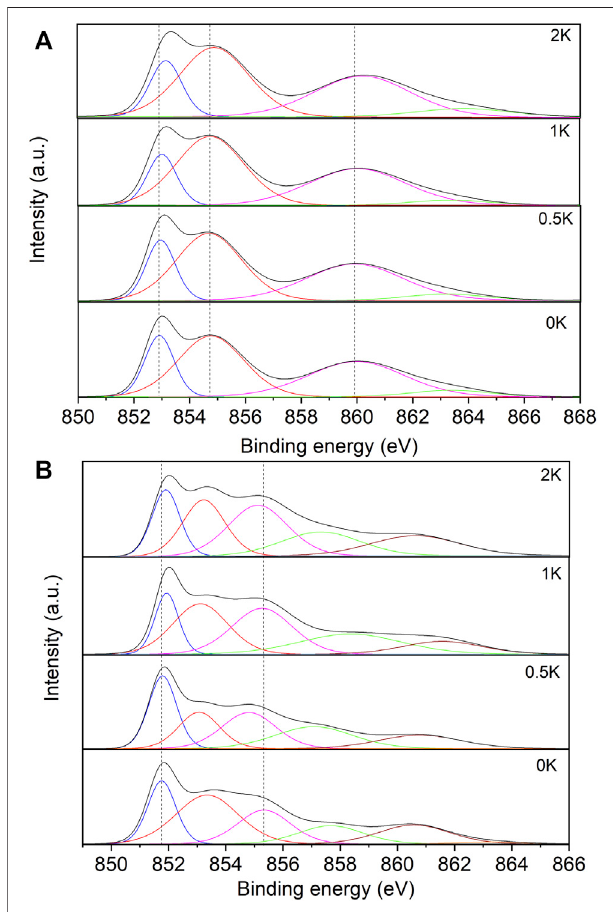
H -TPR 2 The reducibility of the different species and the effect of the incorporation of K in the catalyst was evaluated using H 2 -TPR